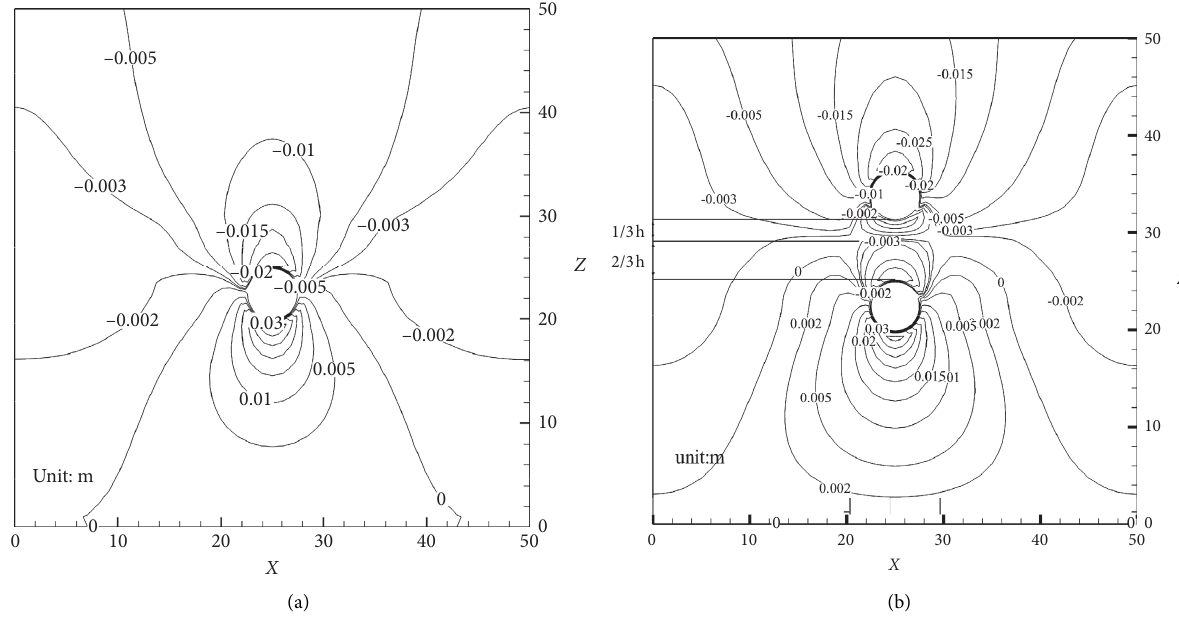
Figure 7: (a) Contour map of the vertical displacement of the stratum after excavation of the lower tunnel. (b) Contour map of the vertical displacement of the stratum after excavation of the upper tunnel (h: the distance between the upper and lower tunnels).